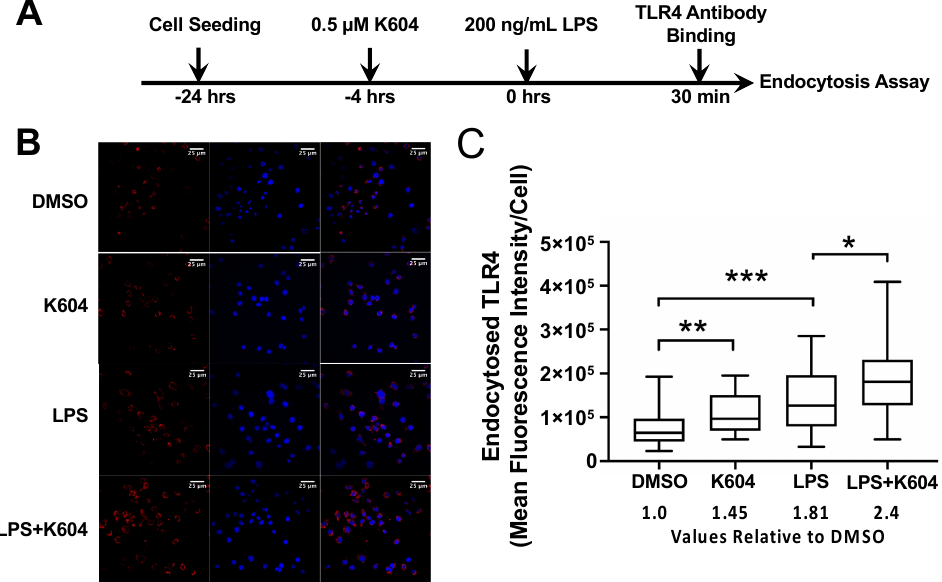
Figure 5. ACAT1/SOAT1 inhibition by K604 increases endocytosis of TLR4 in N9 cells. ( A ) N9 cells seeded on poly-d-lysine-coated glass cover slides in 12-well plates were treated with DMSO or 0.5 µ M K-604 for 4 h followed by treatment with or without 200 ng/mL LPS for very short period (30 min). Endocytosis assay was performed as described in Section 4. ( B ) After treating cells with the primary antibodies against TLR4, the secondary antibodies (red) were used to stain TLR in the cell interior; DAPI stain (blue) was used to stain the nuclei. ( C ) Quantification shows the mean fluorescent TLR signal per cell. The TLR signals were normalized by the nucleus signals. n = 30 cells/treatment group. * p < 0.05; ** p < 0.01; *** p < 0.001.